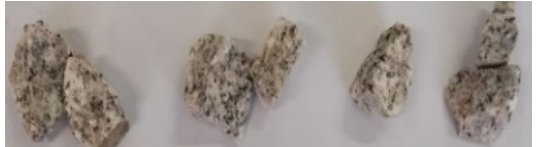
Figure 1. Granite sample.